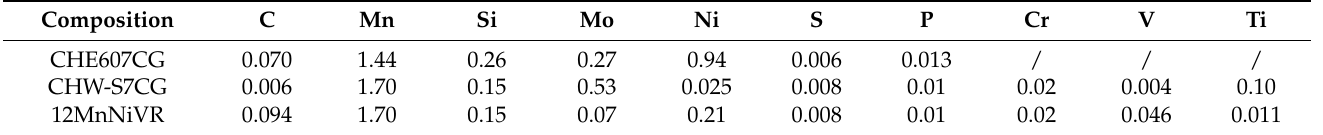
Figure 1. Welding sample structure (unit: mm). Table 1. Chemical composition of base metal and filler metals (wt.%).